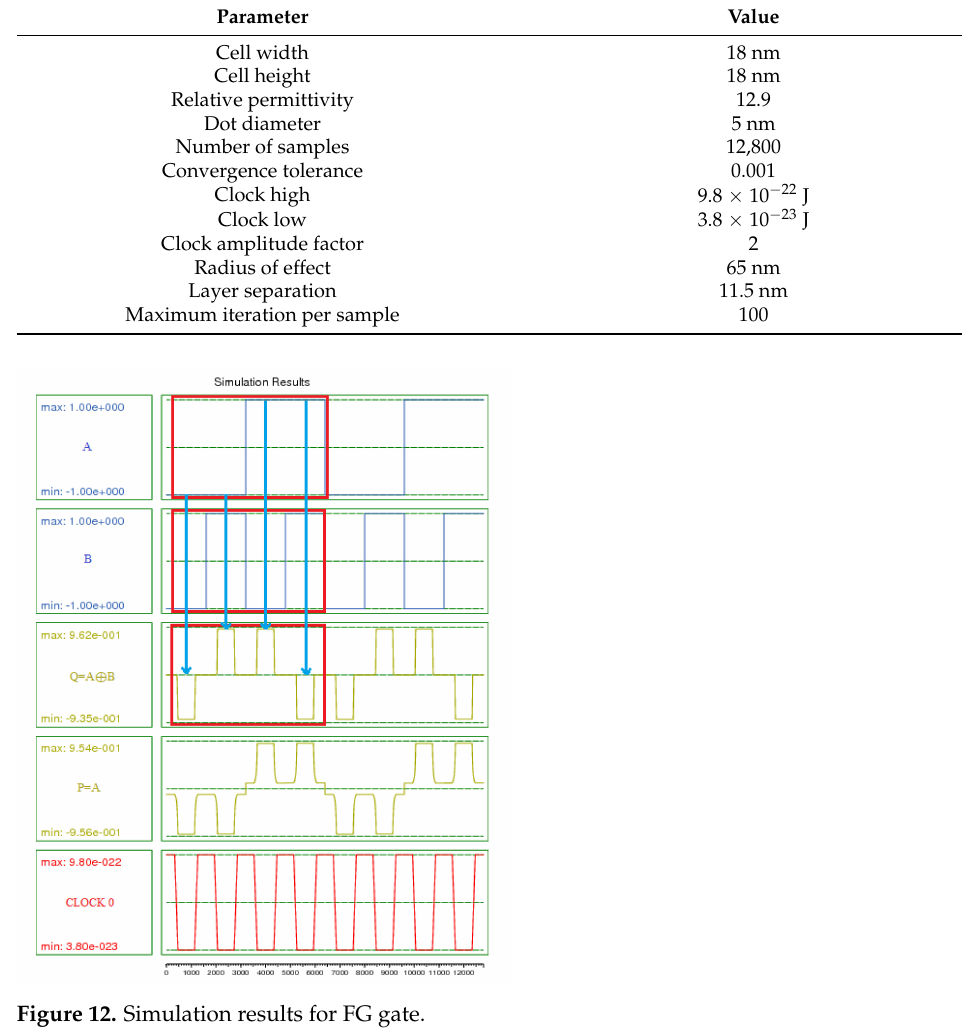
Table 4. Simulation parameters of the coherence vector tool.